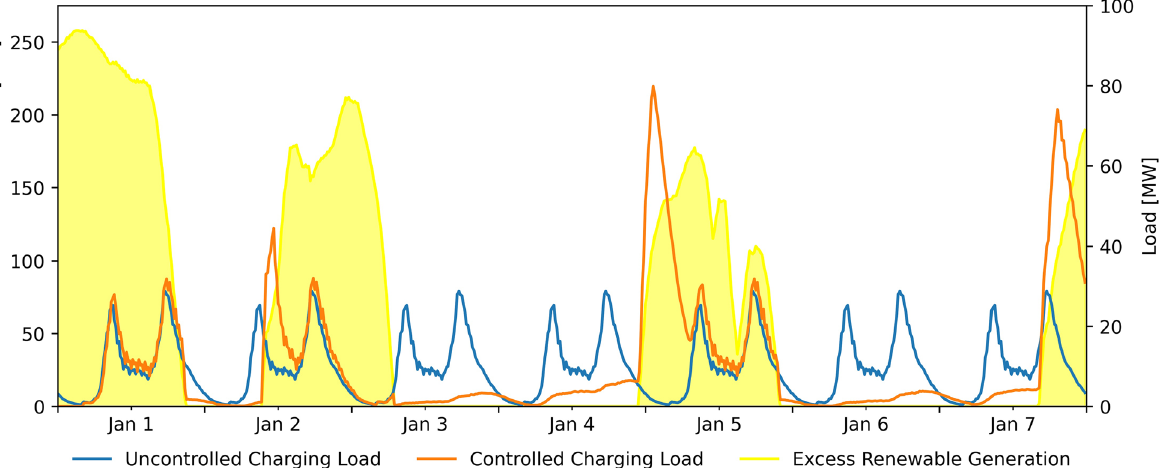
Fig. 7 Correlation between excess renewable energy generation (ERG; left axis, in the yellow area) and total electric vehicle load (right axis) for scenarios of UNC (W-UNC) and UCC (W-UCC) for a January week in Regina in the wind-only